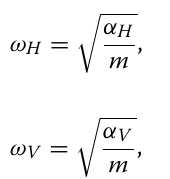
where F x , F y , and F z are the components of the external force exerted on the sphere as viewed from the frame fixed to the gravity sensor. ω H and ω V are the angular eigenfrequencies of the sphere in the horizontal and ver- tical directions, respectively, given